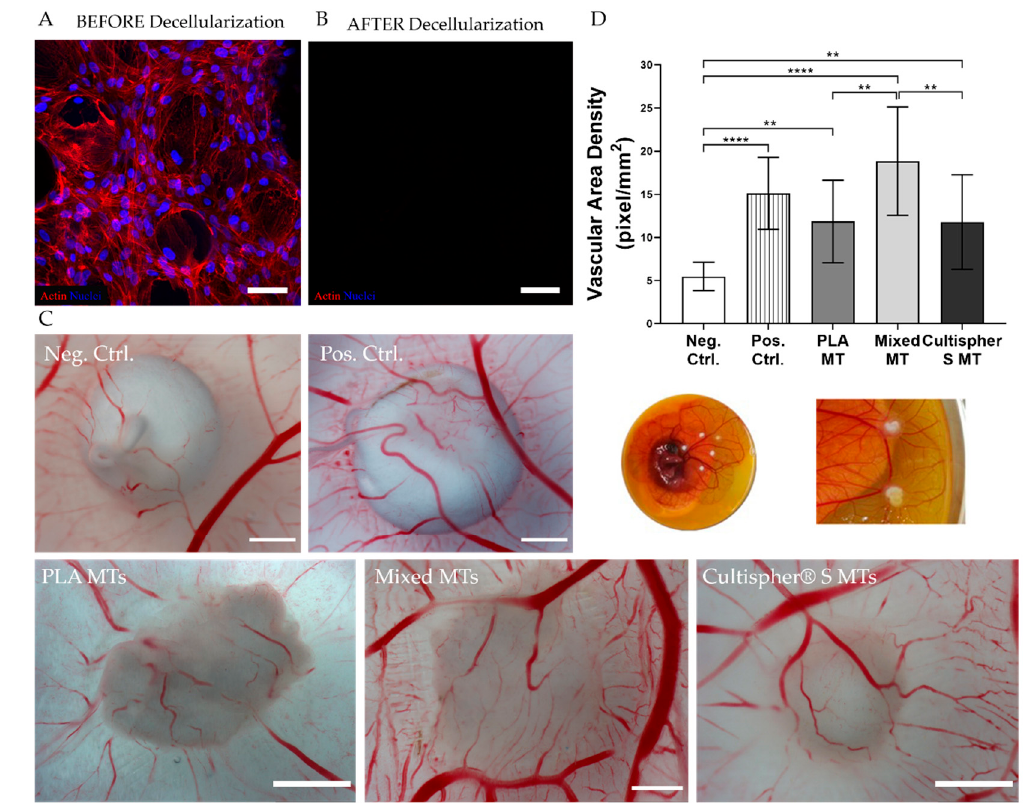
Figure 7. Ex vivo MTs angiogenesis potential. ( A ) MT staining before decellularization and ( B ) after decellularization. Actin (red), nuclei (blue), scale bars = 100 μ m. ( C ) Ex vivo stereomicroscope images from tested conditions, scale bars = 2 mm. ( D ) Vascular area density quantification. ** p -value ≤ 0.01, *** p -value ≤ 0.001, **** p -value ≤ 0.0001.